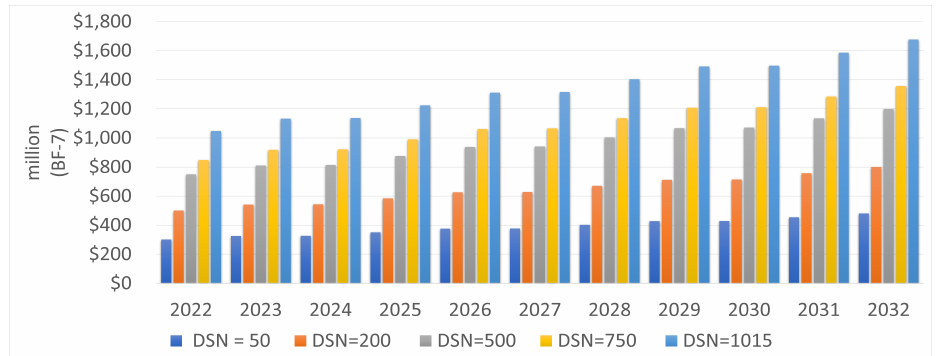
Figure 7. Life-Saving value in AED Delivery (BF-7; see Section